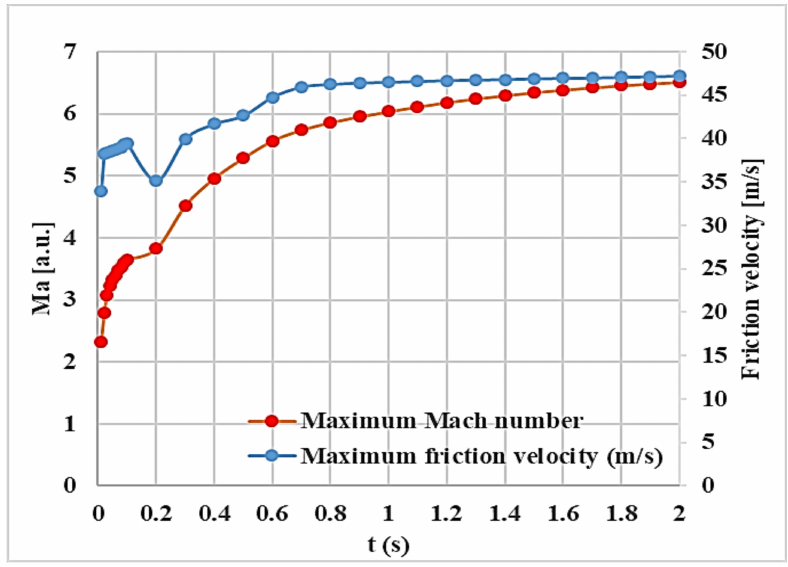
Figure 11. Time evolution of maximum Mach number and maximum friction